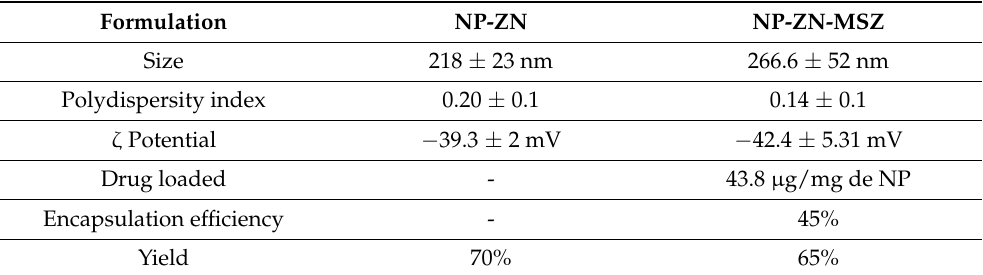
Table 1. Characterization of zein nanoparticles with and without the drug.